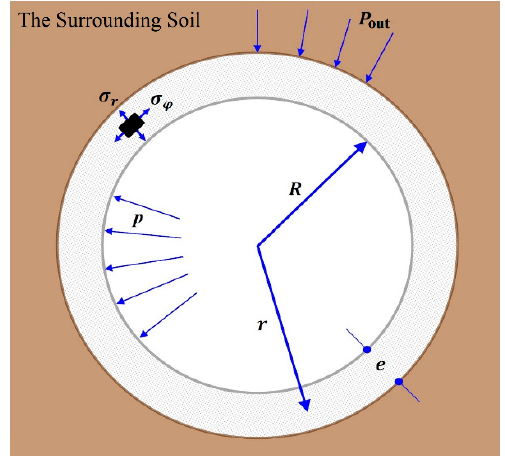
Figure 1. Pressurized pipe cross section.